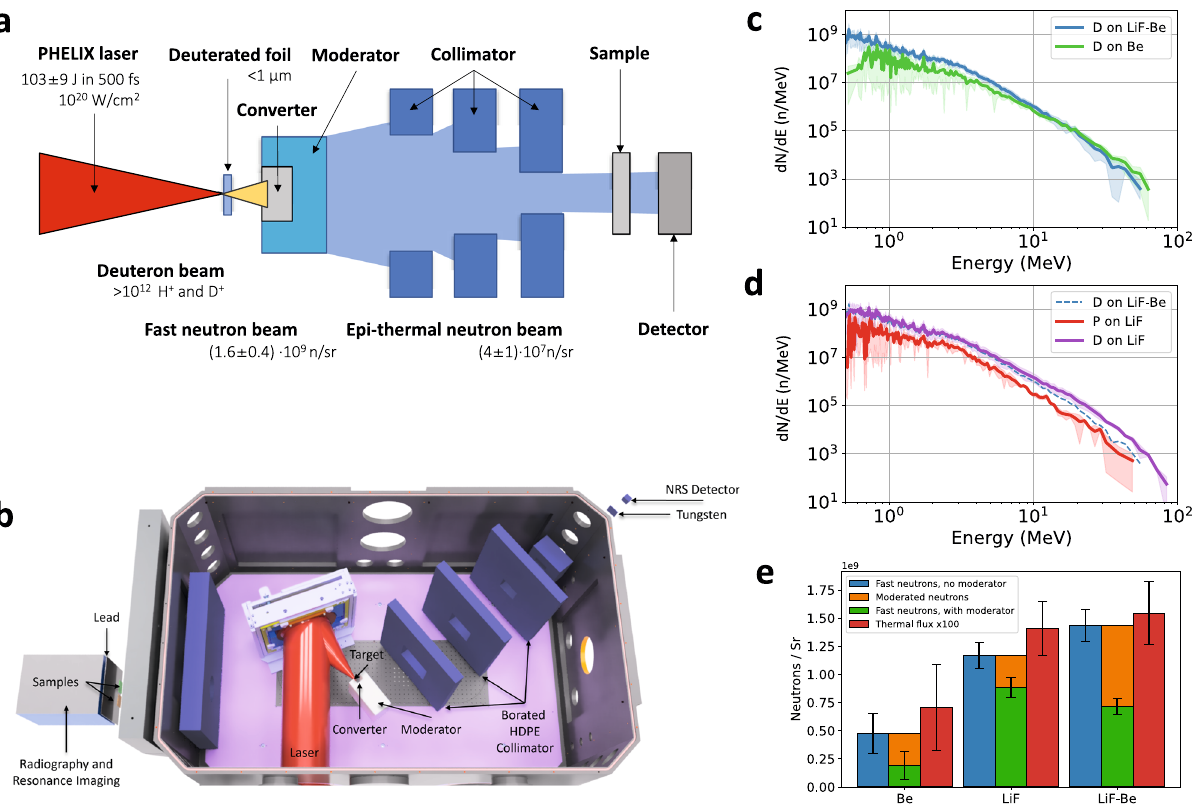
Fig. 1 Optimization of the fast neutron fl ux from laser-driven neutron sources (LDNS). a Schematic setup of an LDNS that produces fast neutrons by the conversion of laser-accelerated protons and deuterons in a Be, LiF, or a LiF-Be converter material. Fast neutrons are subsequently moderated to thermal and epithermal energies. The laser-driven neutron source can be applied for investigating samples with neutron radiography, neutron resonance spectroscopy (NRS), and neutron resonance imaging (NRI). b Experimental setup at the PHELIX laser. The moderated neutrons can be simultaneously utilized for an NRS measurement, neutron radiography or an NRI measurement with samples placed outside of the chamber. c , d Fast neutron spectra measured with a fast scintillator and a photomultiplier for different target and converter combinations. The highest fast neutron fl ux is obtained for deuterated targets and the LiF converter. e Neutrons per steradian are measured for different converter materials. The fast neutron fl ux is measured with bubble detectors (blue, green). The thermal and epithermal neutron fl ux is measured with a borated MCP (red). The error bars indicate the standard deviation of the dataset. The orange bar displays the difference between shots with and without moderator and is an estimate of the moderated neutron for different converter materials. Error bars shown are the statistical standard deviation. The combination LiF-Be provides the highest total neutron yield of (1.43 ± 0.14) ⋅ 10 9 n/sr in agreement with the measurements with the fast scintillators. The green bars show the average neutron fl ux of all bubble detectors with the moderator in place. Accordingly, the difference between those two measurements indicates, which fraction of neutrons is moderated (orange bars). The largest difference is observed with the LiF-Be converter. The thermal neutron fl ux was additionally measured with a borated MCP (red bars). We observed that the combination LiF-Be produces the highest amount of thermalized neutrons. This can be explained by a lower average kinetic energy of neutrons for the LiF-Be converter compared to LiF, which results in a more ef fi cient moderation. For this reason, the LiF-Be combination was favored for the experiment.